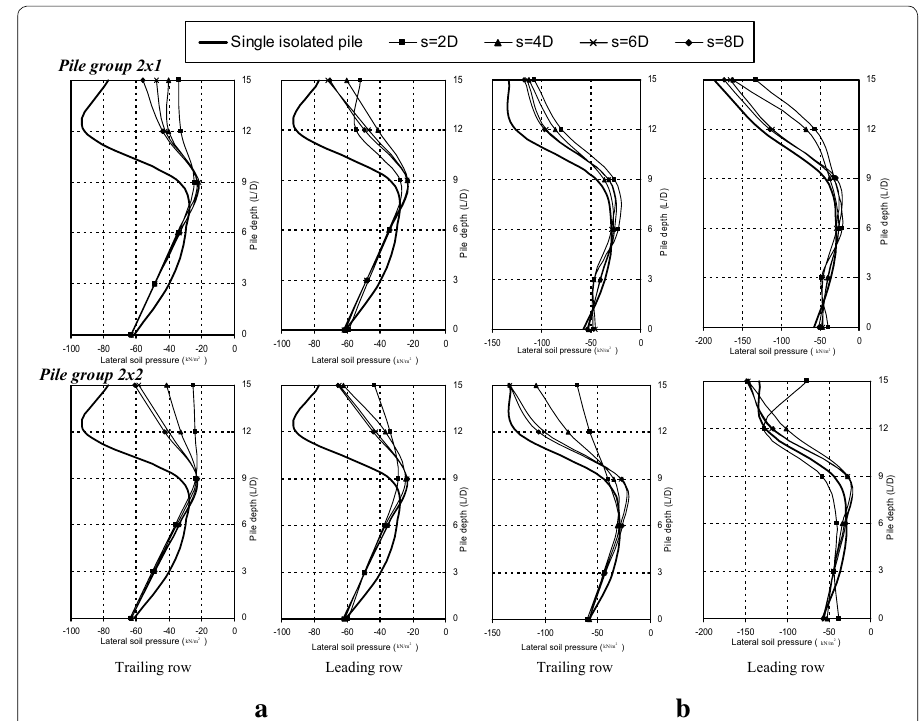
Fig. 6 Influence of pile spacing on the lateral soil pressure with depth of group piles (2 cohesionless soil and b cohesive